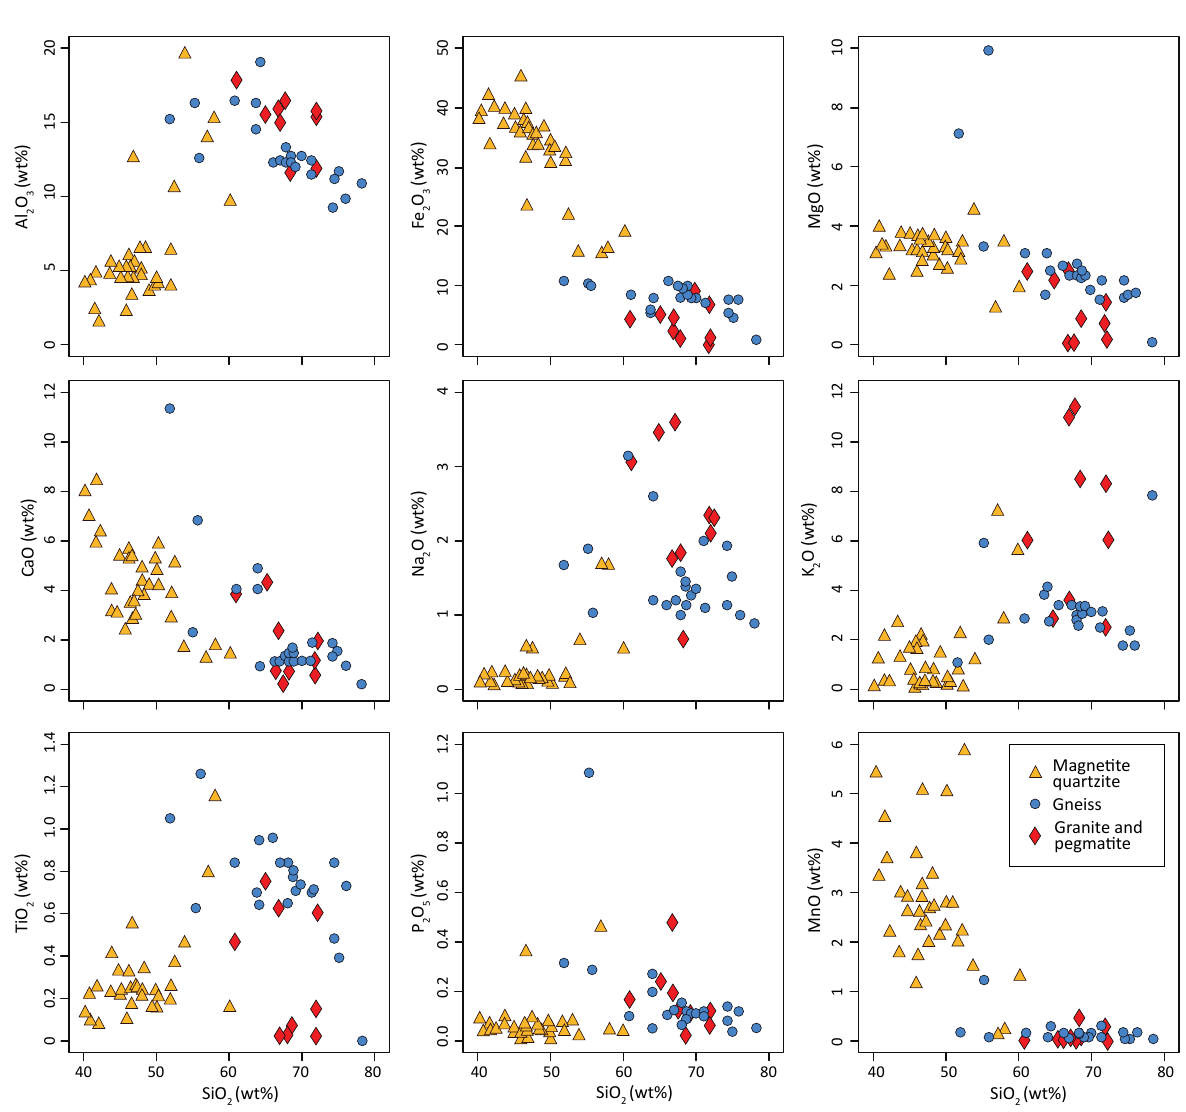
Fig. 5. Geochemical variation plot for selected major oxides in the Jõhvi Zone rock types (in wt%). Selected geochemical analyses in Table 1; full set of analyses at